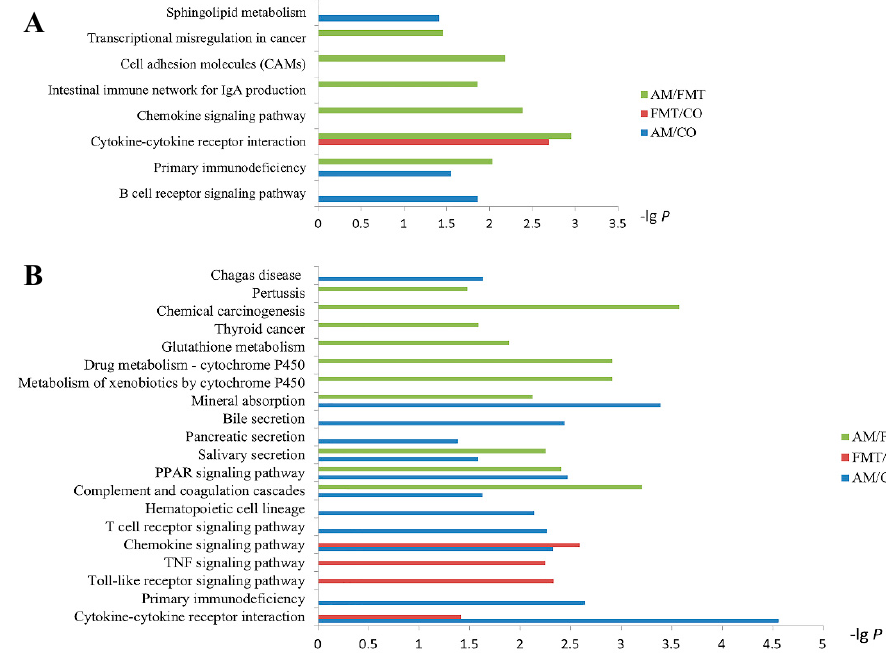
Figure 4. Kyoto Encyclopedia of Genes and Genomes (KEGG) pathway analysis of the di ff erentially expressed genes in the ileum mucosa among the amoxicillin (AM), fecal microbiota transplantation (FMT), and control (CO) groups on ( A ) days 7 and ( B ) 21.